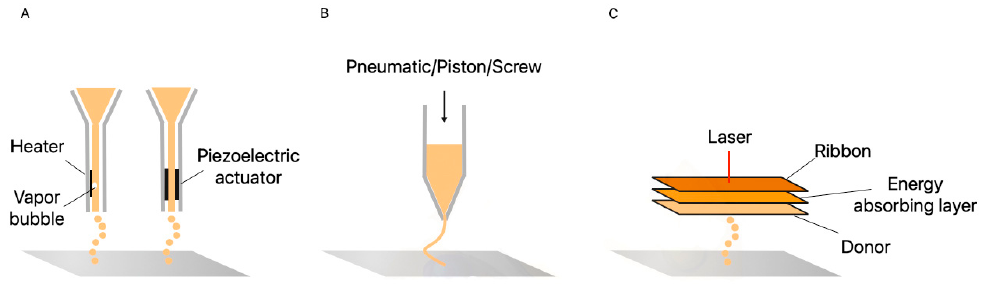
Figure 3. Three main bioprinting technologies: ( A ) inkjet bioprinting; ( B ) extrusion; ( C ) laser-assisted bioprinting.